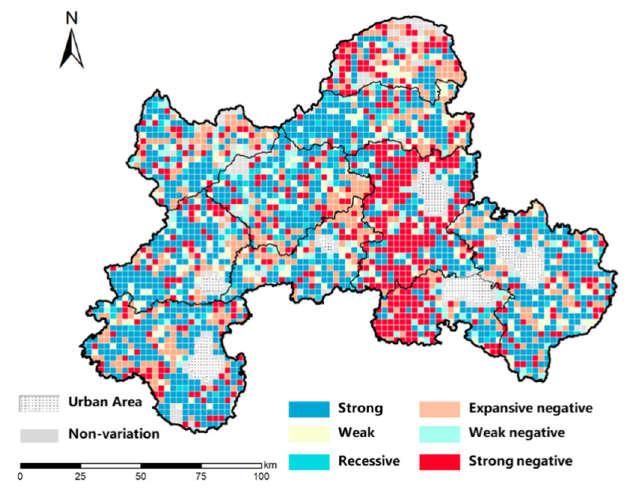
Figure 7. Matching modes within 2.5 km grid during 2009–2018.